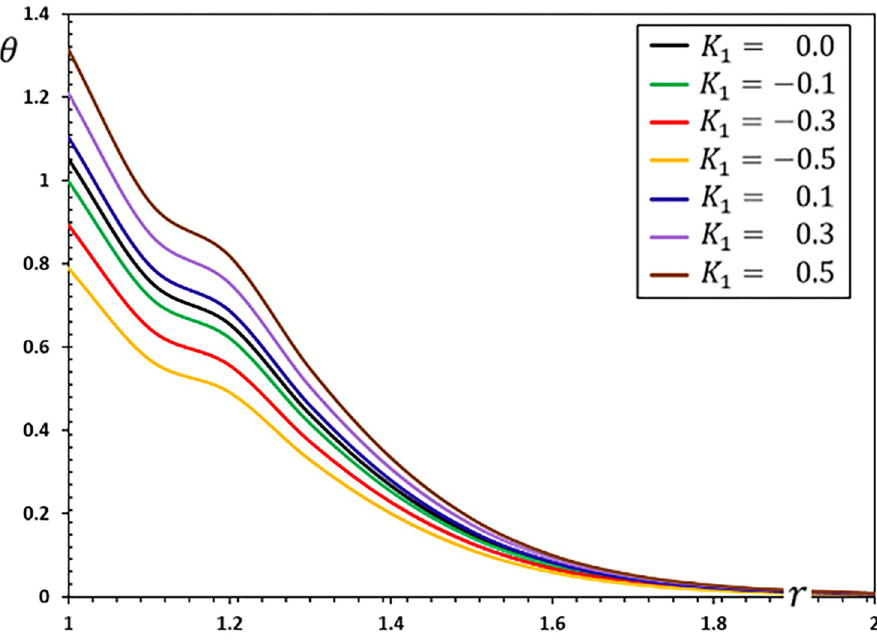
Fig 1. The temperature variation θ for different values of the parameter K 1